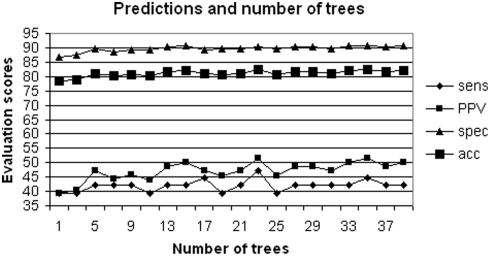
JET and number of distance trees.JET predictions (based on conservation and specific physical-chemical
properties) for Escherichia coli aspartate
transcarbamoylase structure 9atc:A have been evaluated on 625 sequences
obtained with PSI-BLAST. Each of the  tree used contains  sequences. Each dot in the figure corresponds to a
single run of JET.